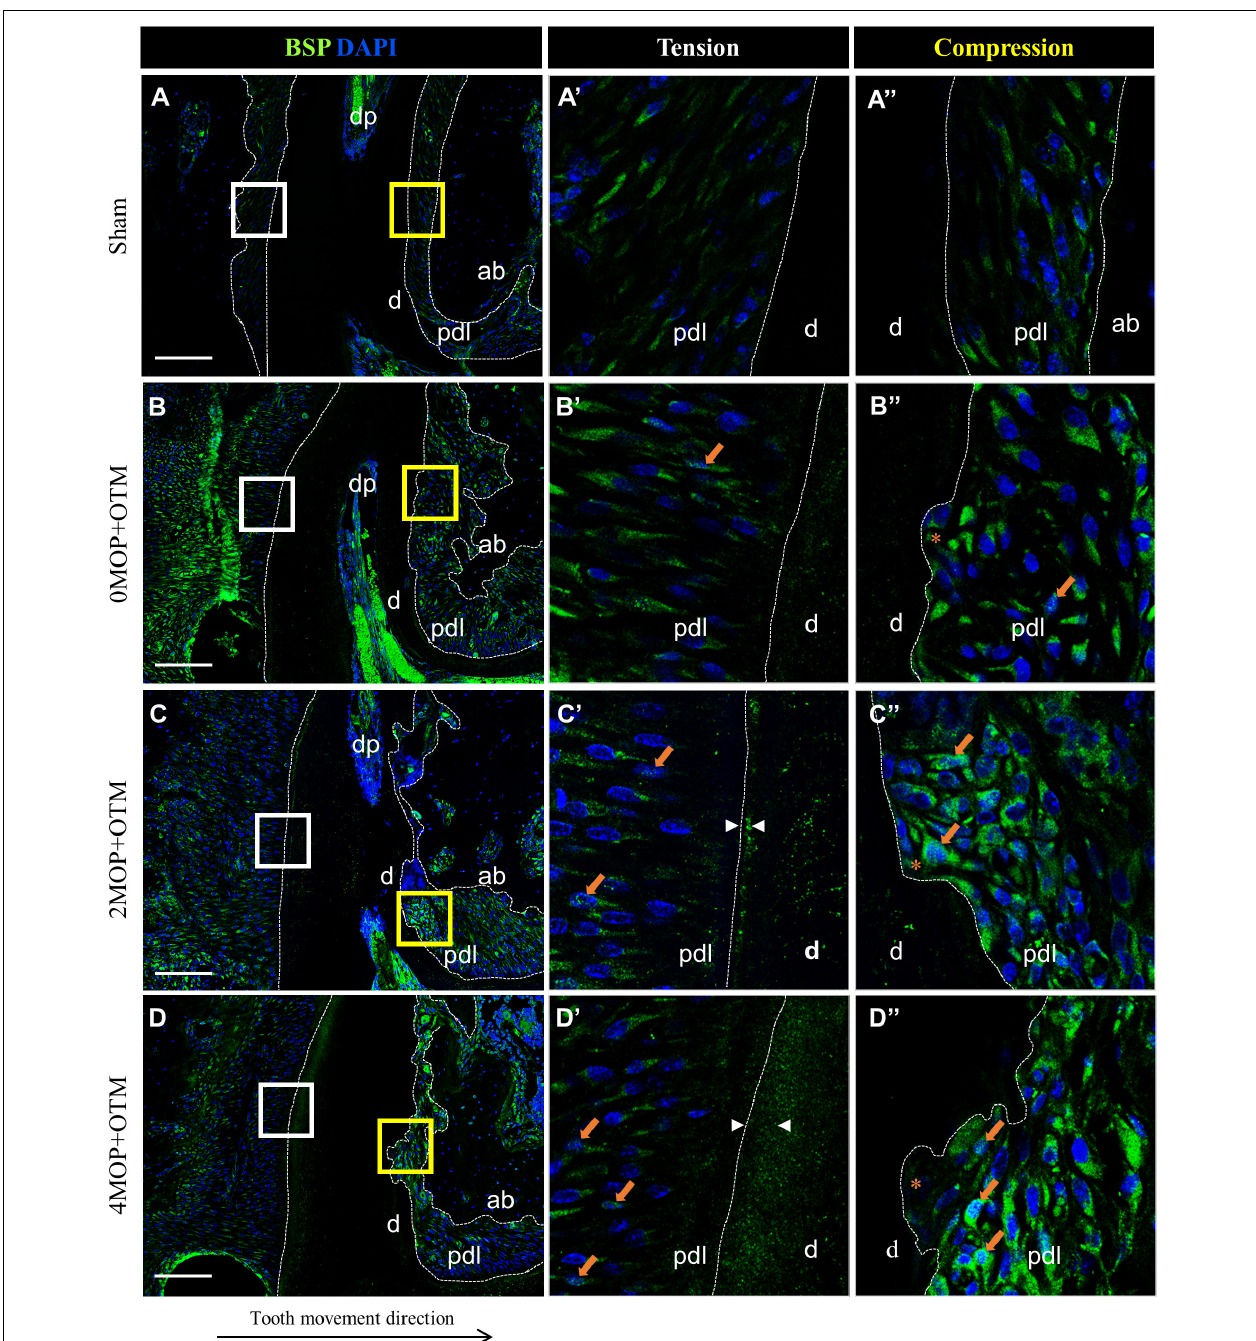
FIGURE 7 | Differential expression of BSP dependent to the number of MOP. (A) In sham group, BSP was evenly expressed in both sides of PDL. (A’) High magnification of tension side. (A”) High magnification of compression side of PDL. (B) BSP expression in 0MOP+OTM group. (B’) High magnification of tension side and (B”) Compression side. BSP expression ( arrow ) was observed stronger in both side of periodontium. (C) BSP expression in 2MOP+OTM group. (C’) In tension side showed moderate to high expression ( arrows ) in PDL, and moderate mineralization ( arrowhead ) was showed on cementum layer. (C”) In compression side, strongest expression was detected on root resorption area compared to the 0MOP+OTM group. (D) In 4MOP+OTM group, BSP expression was showed highly increased cementum mineralization on tension side ( arrowhead ) and increased expression on compression side ( arrows ) compared to other groups. (D’) The tension side was observed slight moderate expression on PDL tissue and strongest mineralization of cementum layer. (D”) The compression side, slightly moderate expression of BSP was detected on crater area compared to 2MOP+OTM group. (Dashed lines, outlines of PDL area; d, dentin; p, periodontal ligament; ab, alveolar bone; dp, dental pulp; asterisks ( ∗ ) indicate root resorption area; arrow, examples of single stained cells; arrowhead, mineralization thickness of acellular cementum; Scale bars = 100 µ m).